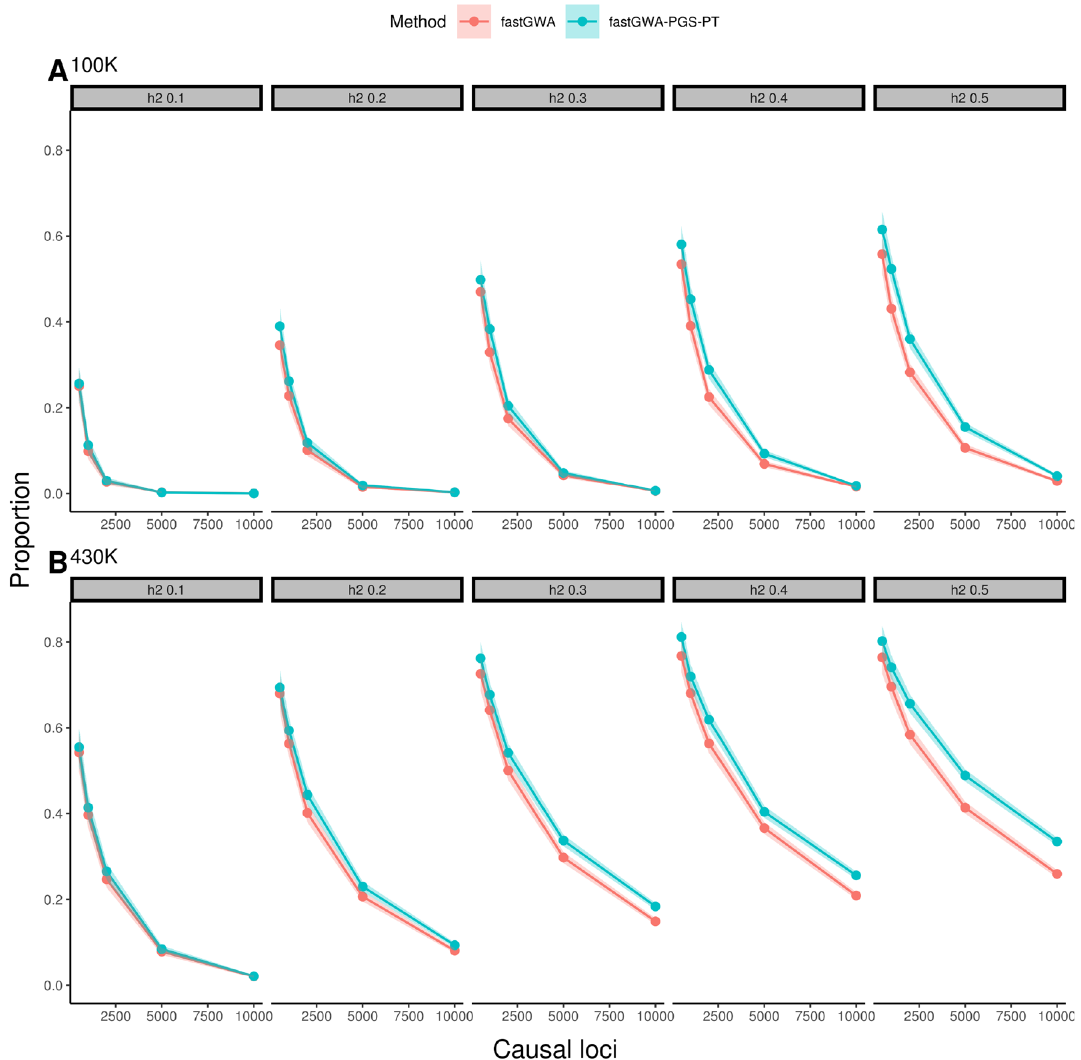
Figure 3. Proportion of causal variants recovered in simulations of a quantitative trait over a range of values of h 2 and the number of causal loci. Simulations on the top ( A ) and bottom ( B ) panels were based on 100,000 and 430,000 randomly sampled individuals from the UK Biobank,